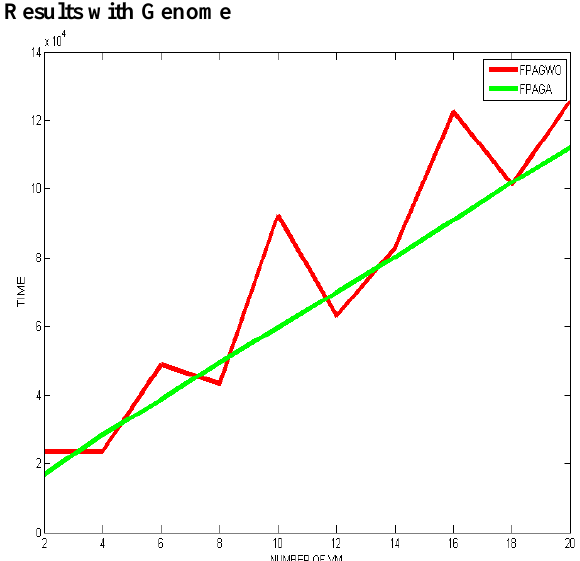
Figure 7. Time on Sight workflow for